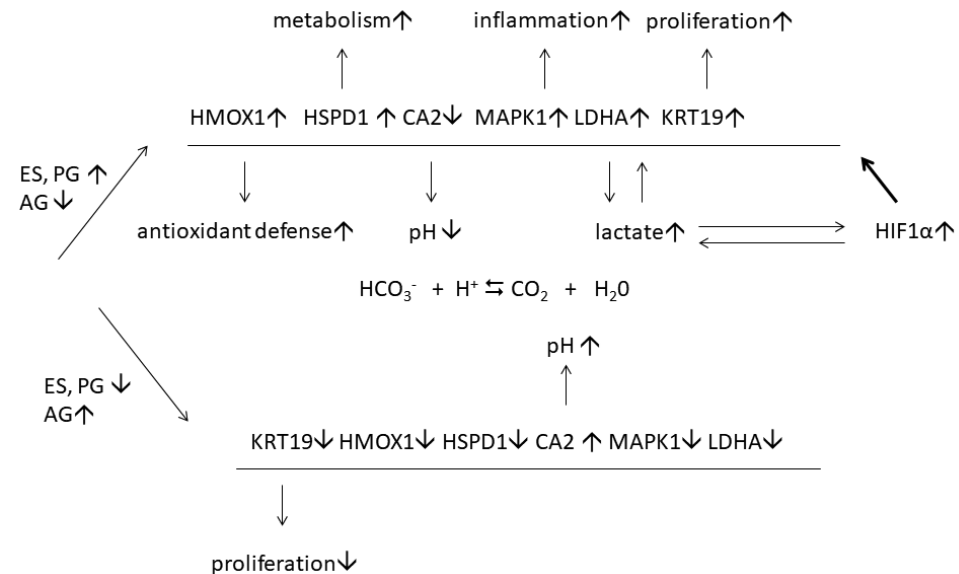
Figure 4. The regulation of estrogen-responsive proteins in lesional skin of female psoriasis patients. The signs ↓ and ↑ indicate that the protein expression is increased and decreased, respectively. The sign indicates that chemical reaction between HCO 3 − and can be reversed [48].